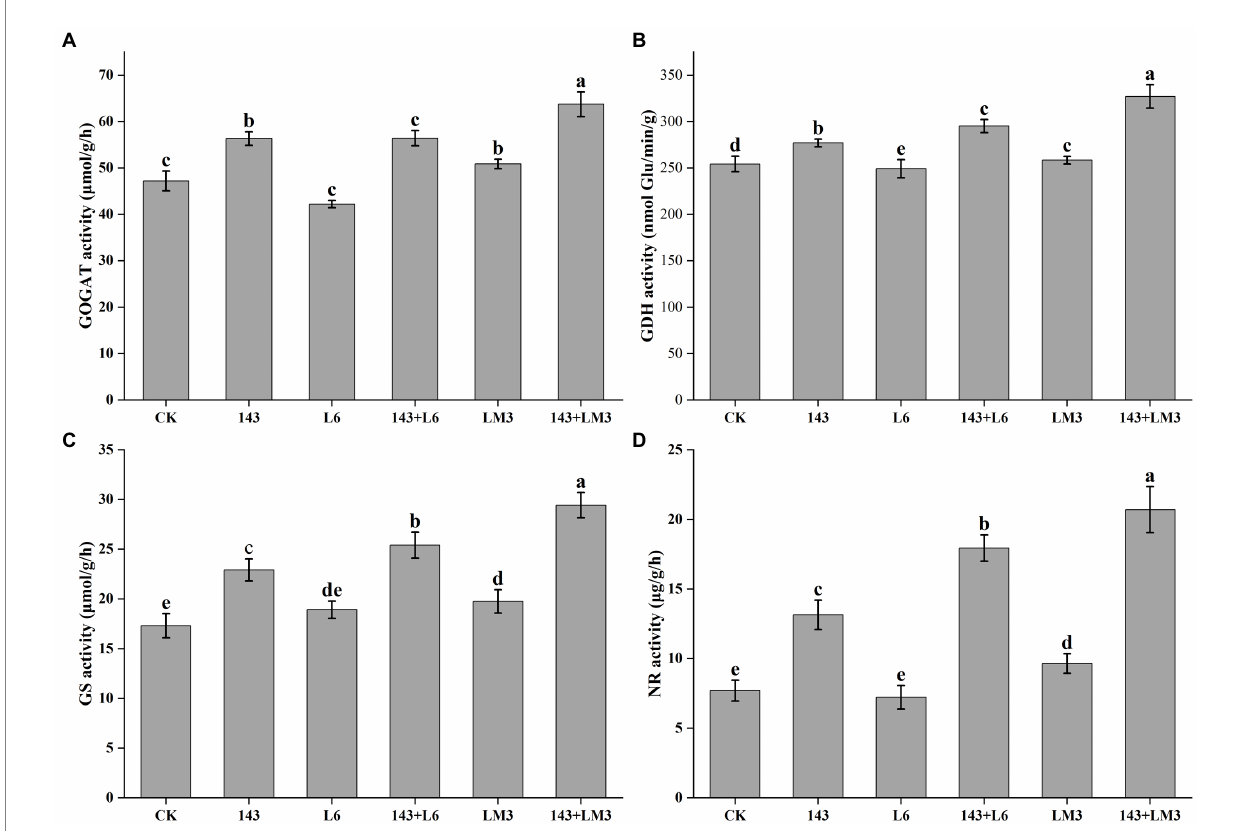
FIGURE 4 Effects of potential MHB strains and O. maius 143 on the enzyme activities of blueberry leaves. (A) Effect of potential MHB strains and O. maius 143 on the GOGAT activity of blueberry. (B) Effect of potential MHB strains and O. maius 143 on the GDH dismutase activity of blueberry. (C) Effect of potential MHB strains and O. maius 143 on the GS activity of blueberry. (D) Effect of potential MHB strains and O. maius 143 on the NR activity of blueberry. CK is the control without any inoculums. The treatments labeled with different letters are significantly different according to Tukey’s HSD at p < 0.05. Bars represent the standard deviations of the means.